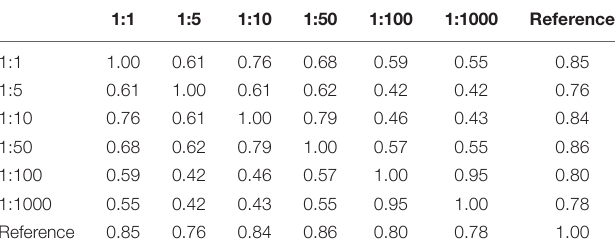
TABLE 2 | Similarities in the gas chromatographic fingerprints among samples treated with six different ratios (1:1, 1:5, 1:10, 1:50, 1:100, and 1:1000) of L. plantarum P-8 to starter culture at 0 d of storage.